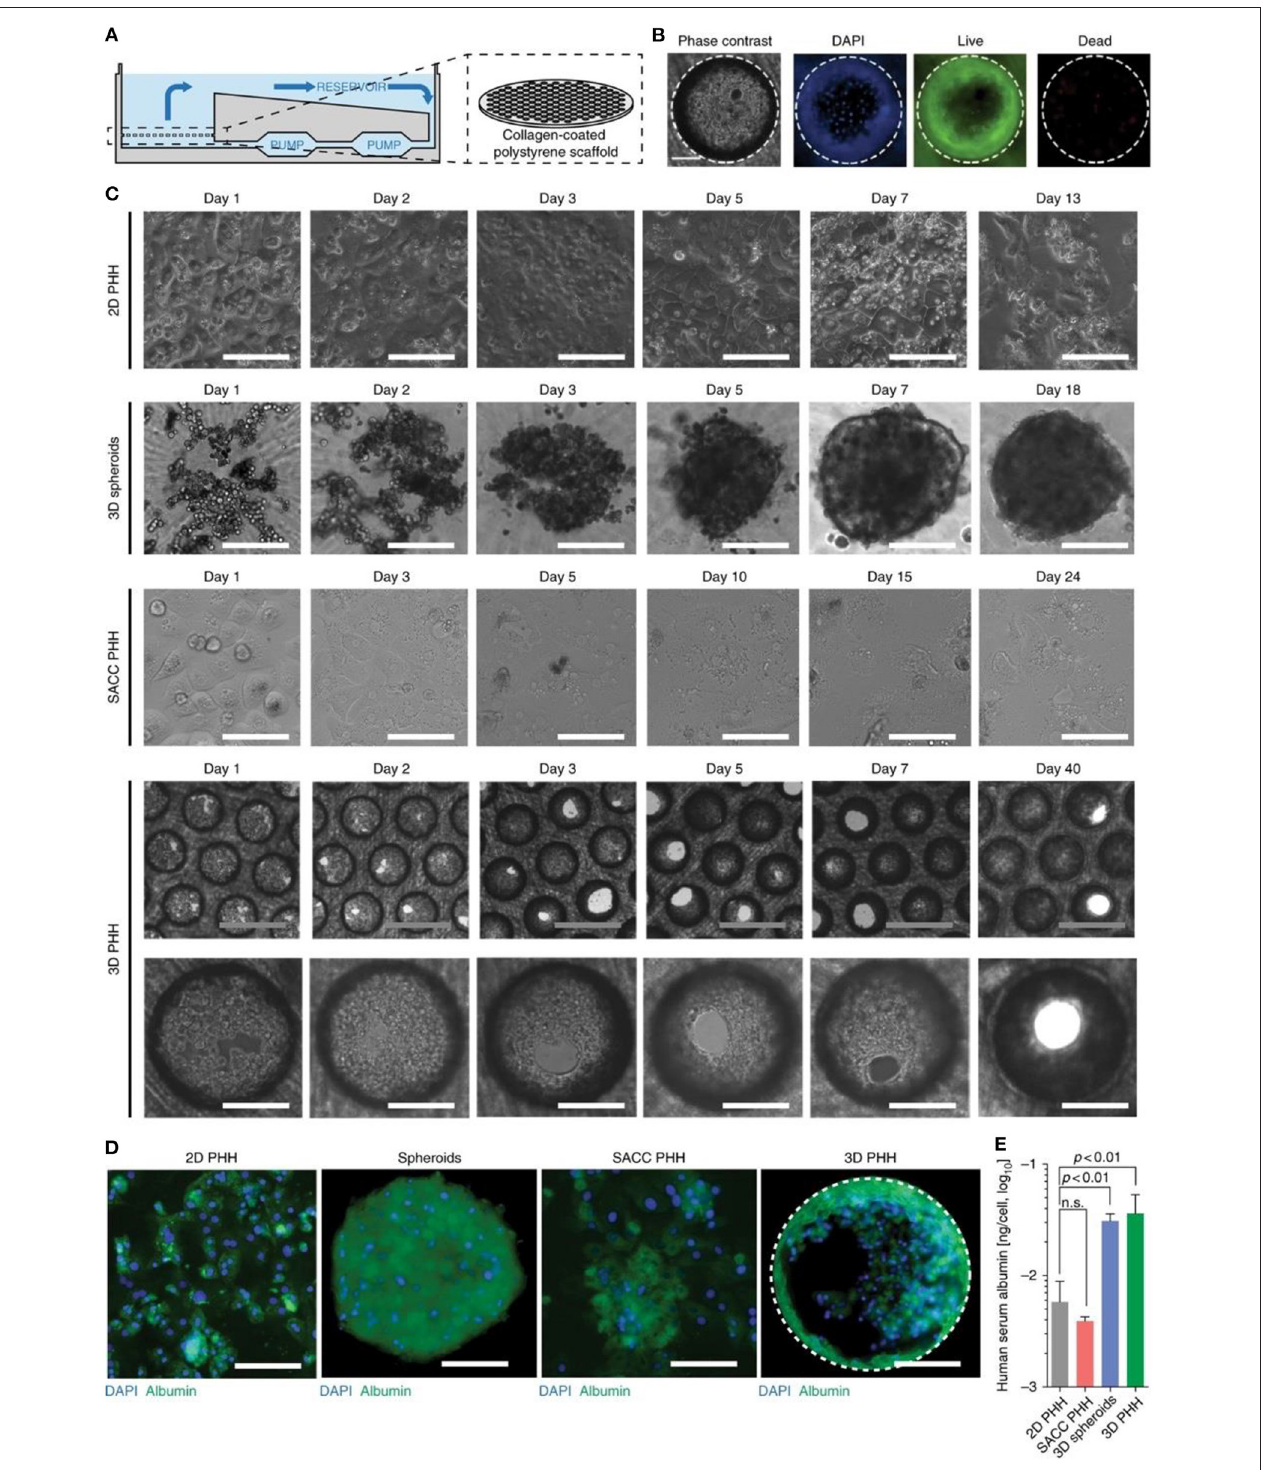
FIGURE 9 | 3D microfluidic system with primary human hepatocytes cultured in a bioreactor. (A) Illustration of the bioreactor showing continuous pumping of media and a collagen-coated scaffold. (B) Cell viability 13 days after seeding 3D cultures. (C) Comparison of the various cell cultures: 2D hepatocytes, 3D spheroids, hepatic and mouse fibroblasts (SACC PHH), and 3D hepatocytes. (D) Immunofluorescence of cell cultures 14 days after seeding. (E) Albumin secretion from cultures 14 days after seeding from ELISA. White scale bars are 200mm and gray scale bars are 500mm. This figure is reprinted under the terms of the Creative Commons Attribution License from Ortega-Prieto et al.